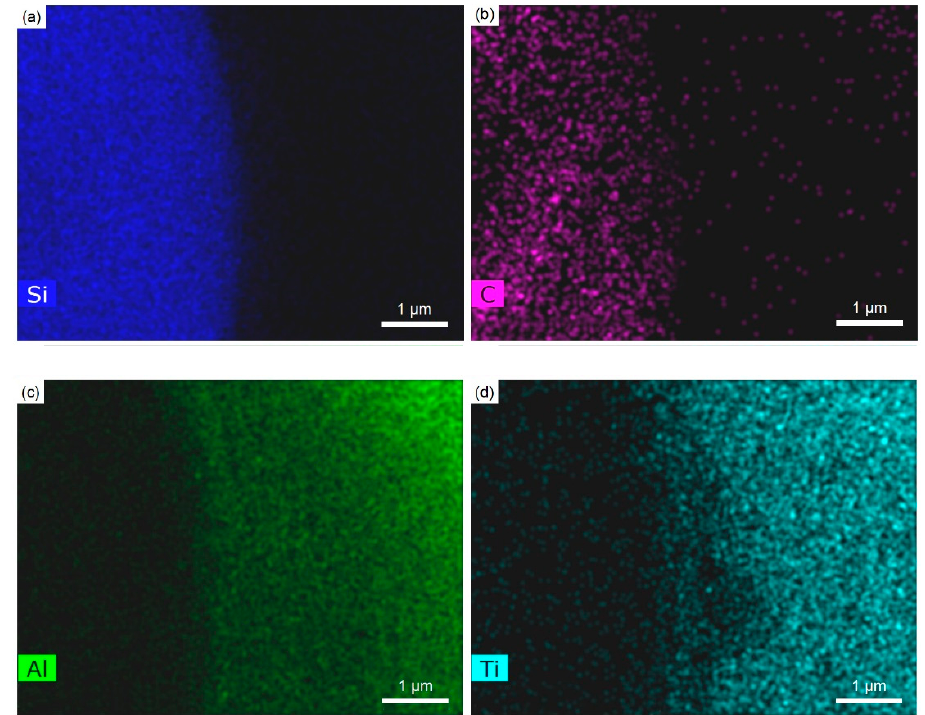
Figure 13. The element distribution maps of ( a ) Si, ( b ) C, ( c ) Al, and ( d ) Ti in the SiC f /Al 3 Ti interfacial zone.